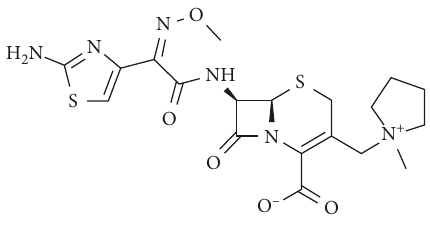
Figure. 1: The zwitterion form of cefepime